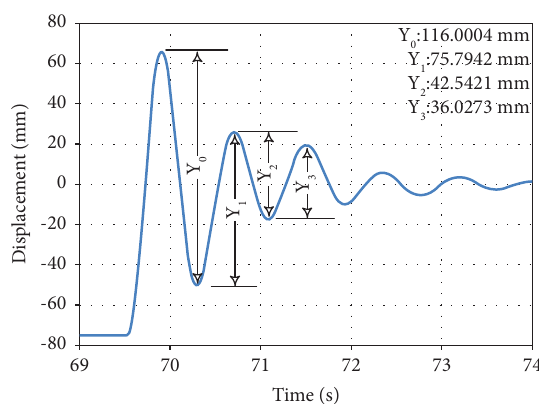
Figure 12: Displacement decay curve of the spacer damper